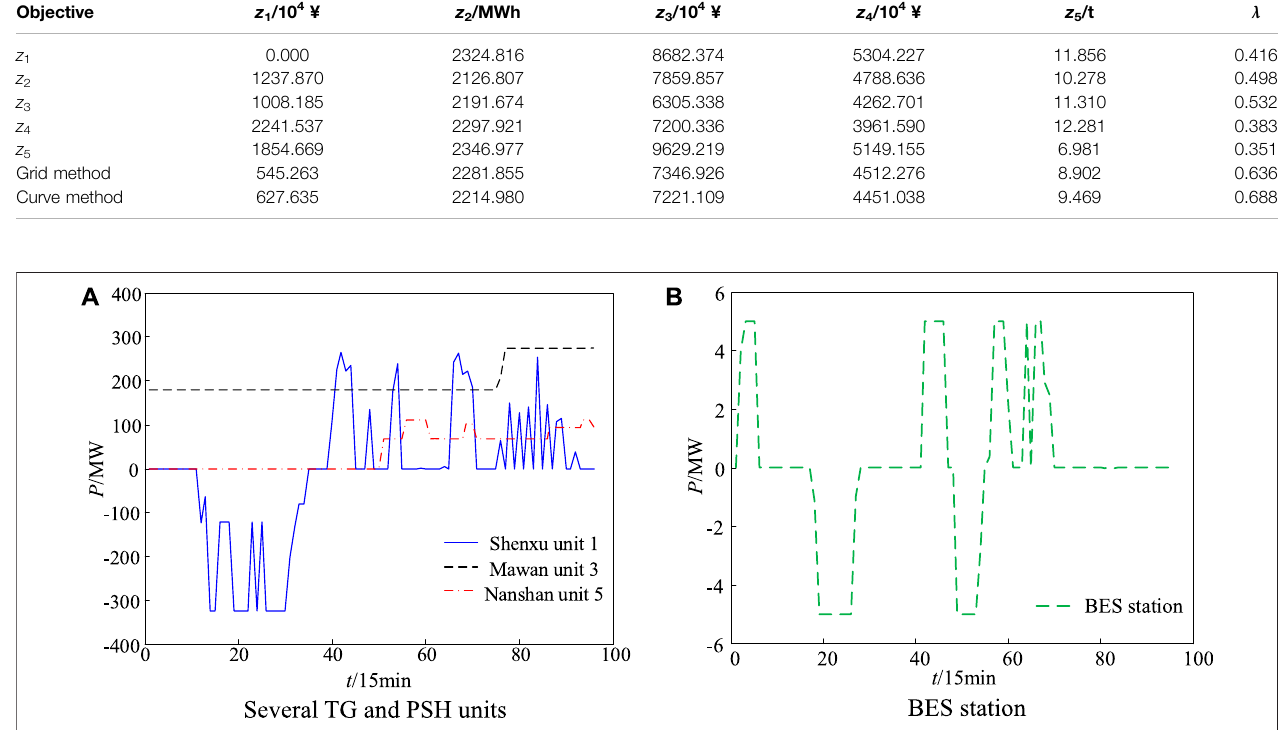
FIGURE 8 | Power output schedules of some units. (A) Several TG and PSH units. (B) BES station.